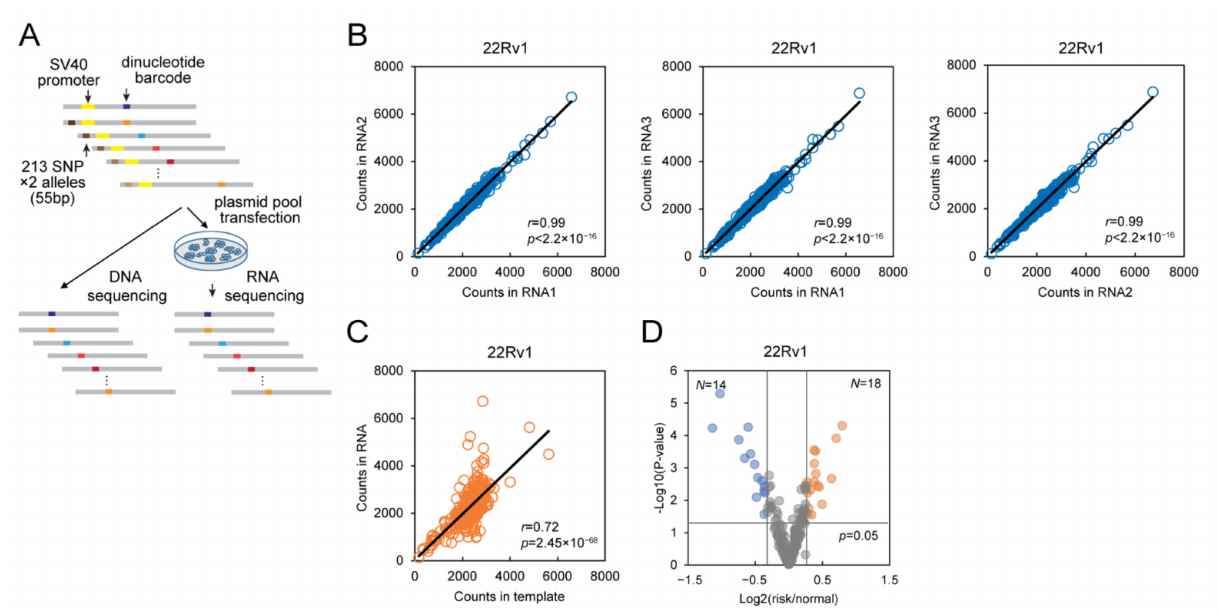
Figure 1. DiR-seq assays discovered regulatory SNPs in prostate cancer cells. ( A ) Flowchart of the DiR system for reporter gene assay in prostate cancer cells. The DiR plasmid library was developed based on the pGL3-promoter vector by optimizing the luciferase coding sequence. The 55 bp SNPs fragment was inserted upstream of the SV40 promoter, 450 bp dinucleotide-barcoded sequences were used as the reporter gene. ( B ) Consistency evaluation between individual biological replicates of DiR-seq assay of 213 prostate cancer risk SNPs in 22Rv1 cells. The correlation coefficient values and p values were calculated with Pearson correlation analysis ( C ) Scatter plot of DiR-seq tag counts in RNA and DNA template in 22Rv1 cells. The correlation coefficient values and p values were calculated with Pearson correlation analysis. ( D ) Volcano plot of the allelic ratio of reporter expression levels in DiR-seq analysis in the 22Rv1 cell line. p values came from a two-tailed Student’s t -test of the reporter expression of individual alleles. The blue dots represent SNP sites satisfying the criteria of fold change < 0.8, p < 0.05, and the orange dots represent SNP sites satisfying the criteria of fold change > 1.2, p <